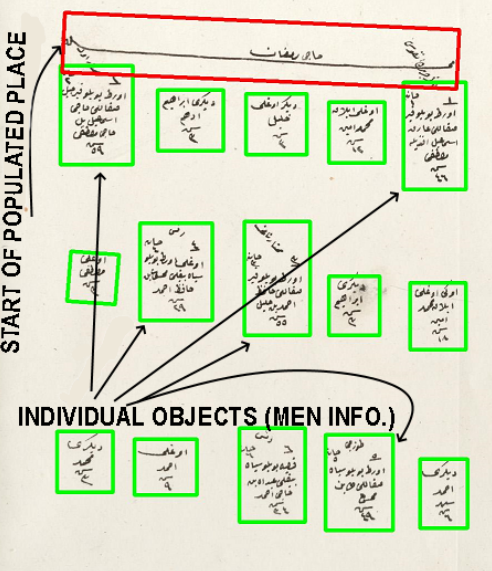
Figure 2. Start of the populated place (village or neighborhood) symbol and individual objects are demonstrated. When a new populated place is registered, its name is written at the top of a new page (populated place start symbol). Then, all men in this place are written one by one (individual objects). These objects include the name, age, appearance, and job of the individuals.